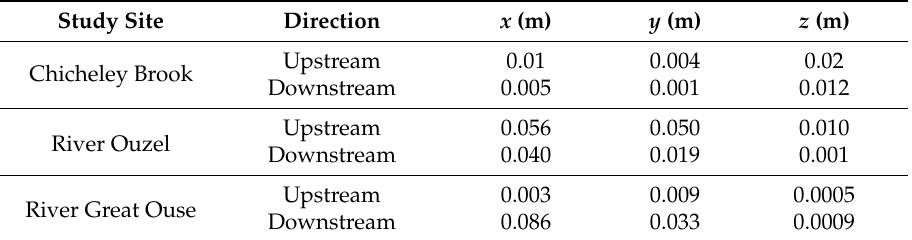
Table 7. Co-registration errors obtained from the 3D Structure from Motion (SfM) model of the riverine environment at each 40 m study site. The stereo-camera height at the three sites was 1 m above the water level.